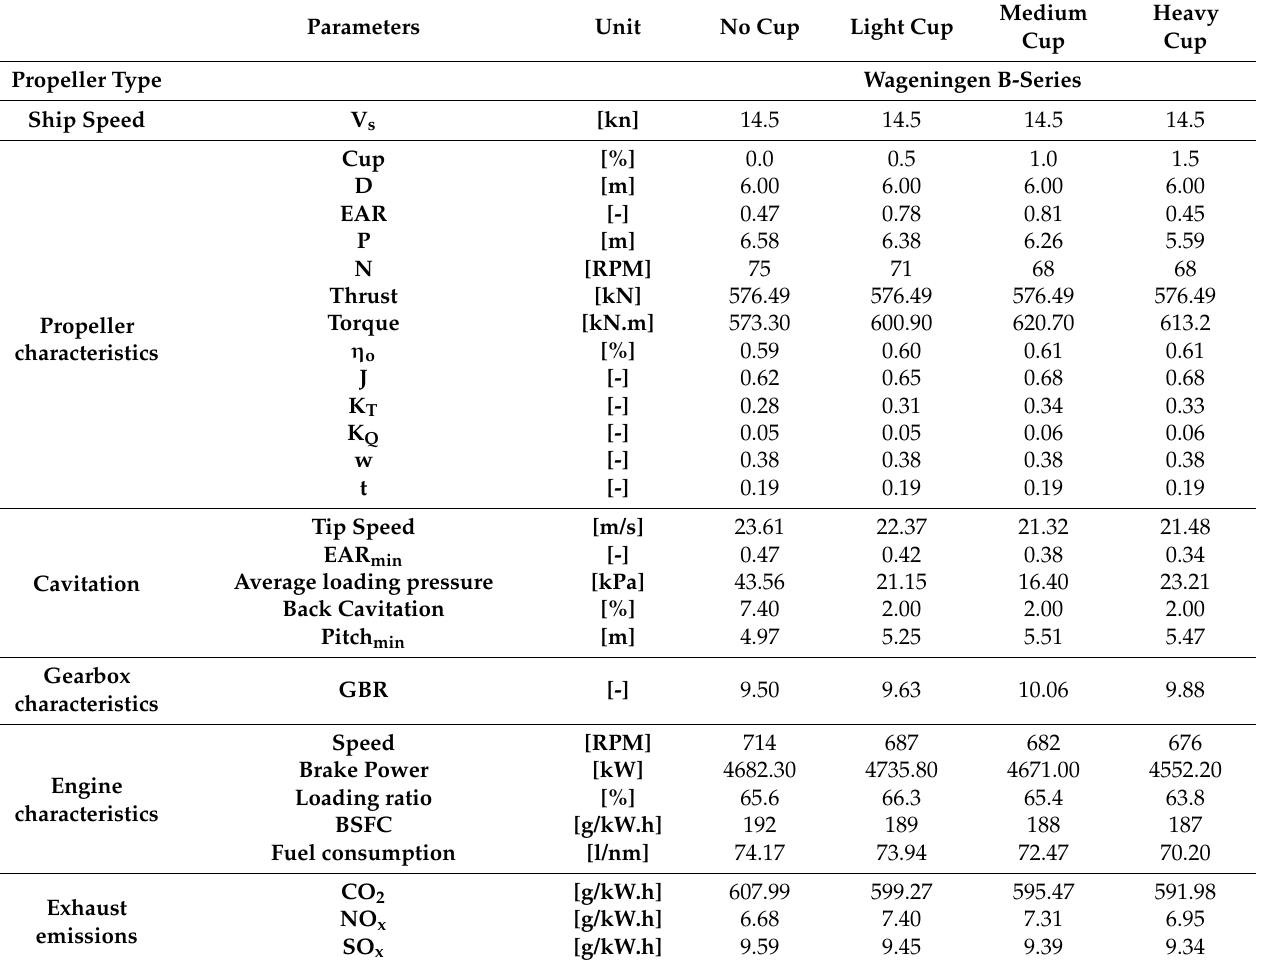
Table 3. Propeller characteristics for different percentages of